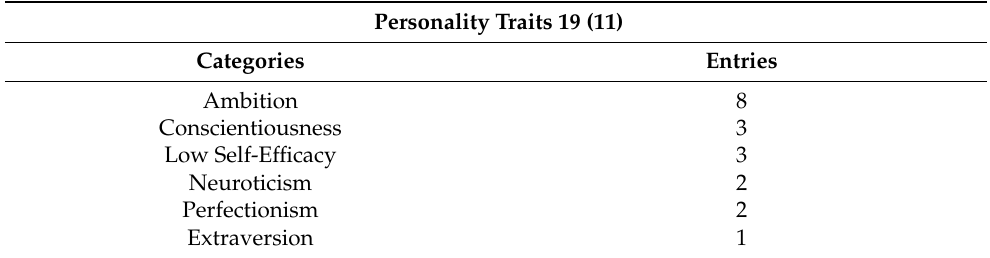
Table 8. Results of the open-ended questions on the reasons for presenteeism (personality traits).